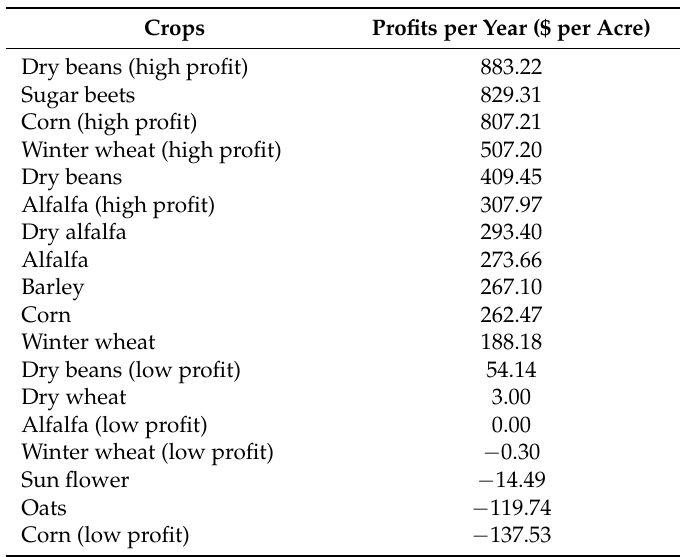
Table 2. Profits for single